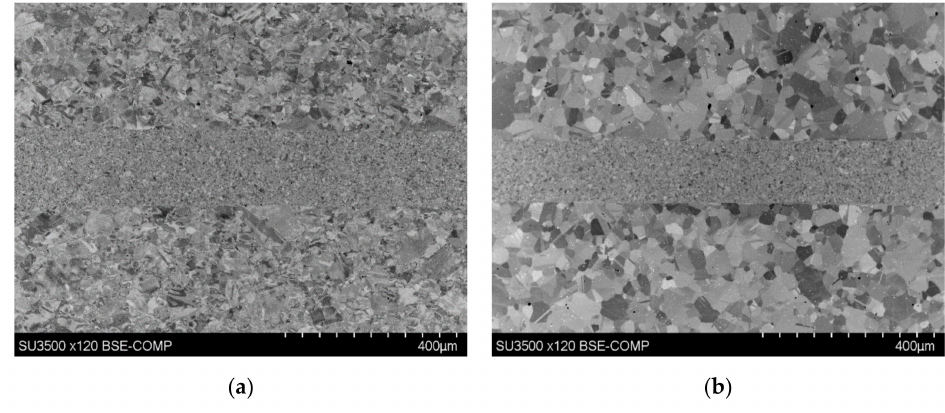
Figure 8. SEM images of ( a ) bond 3 (bonded at 1100 ◦ C) and ( b ) bond 4 (bonded at 1050 ◦ C).